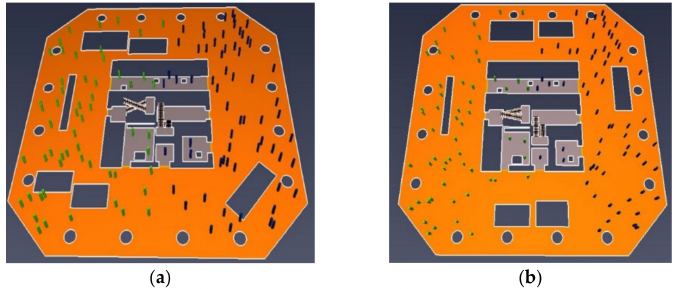
Figure 12. Construction layout of frame working face. ( a ) construction layout without optimization;